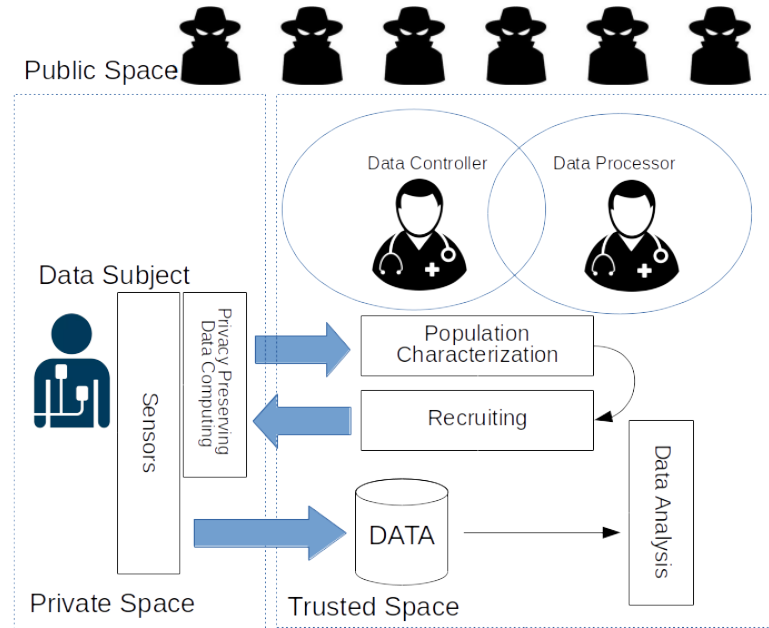
Figure 4. A simplified representation of the privacy-preserving characterization and recruiting phases of clinical trials. Once the user agrees to enroll, data are treated as in the common approach depicted in Figure